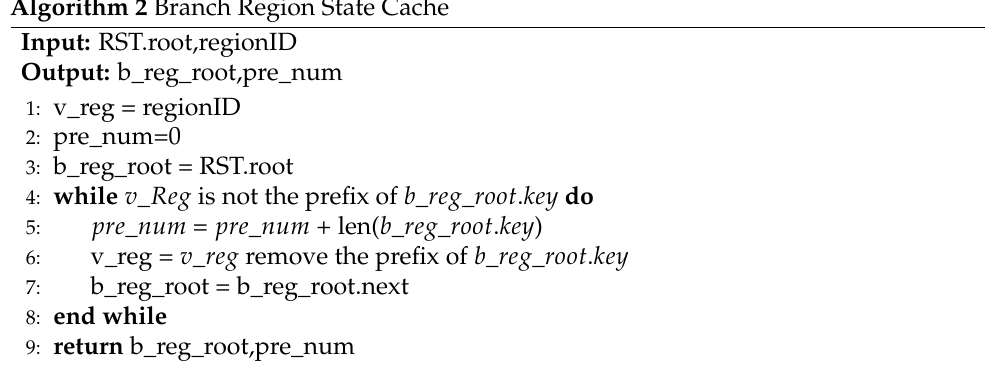
Algorithm 2 Branch Region State